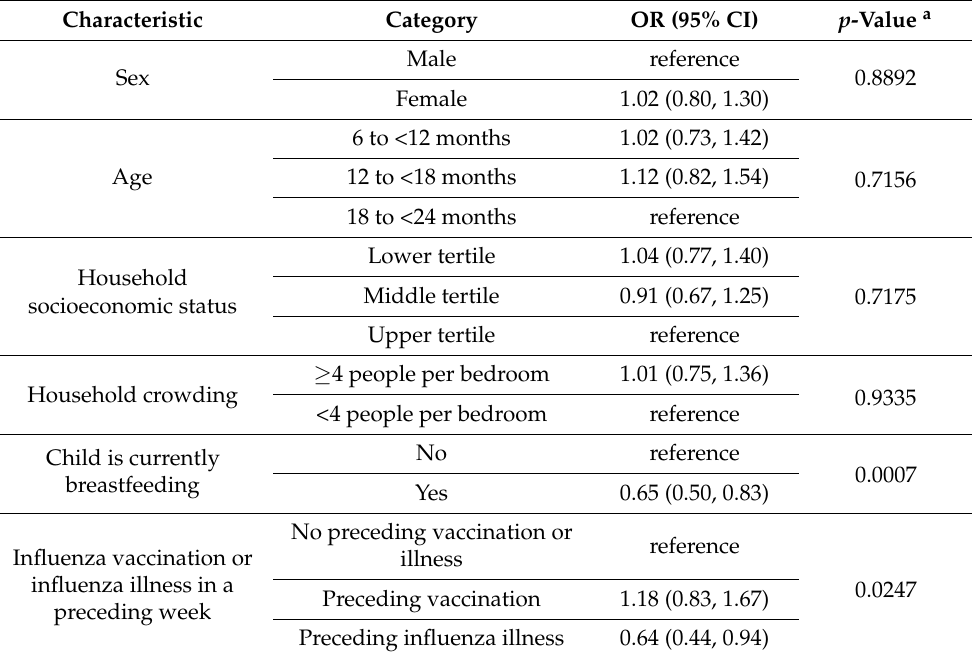
Table 2. Logistic regression model for influenza illness incidence among children 6–23 months old in Managua, Nicaragua ( N = 53,750 person-weeks).